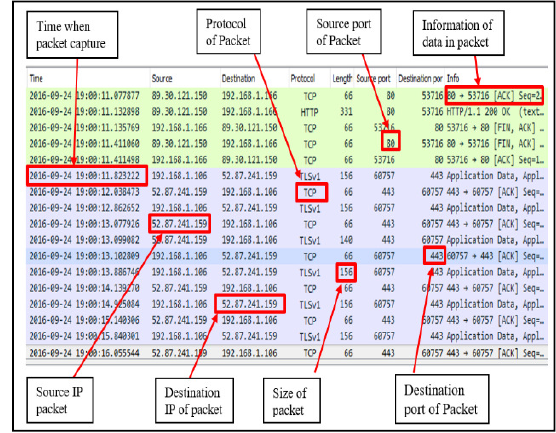
Fig. 6: Network Traffic Traces in Wireshark